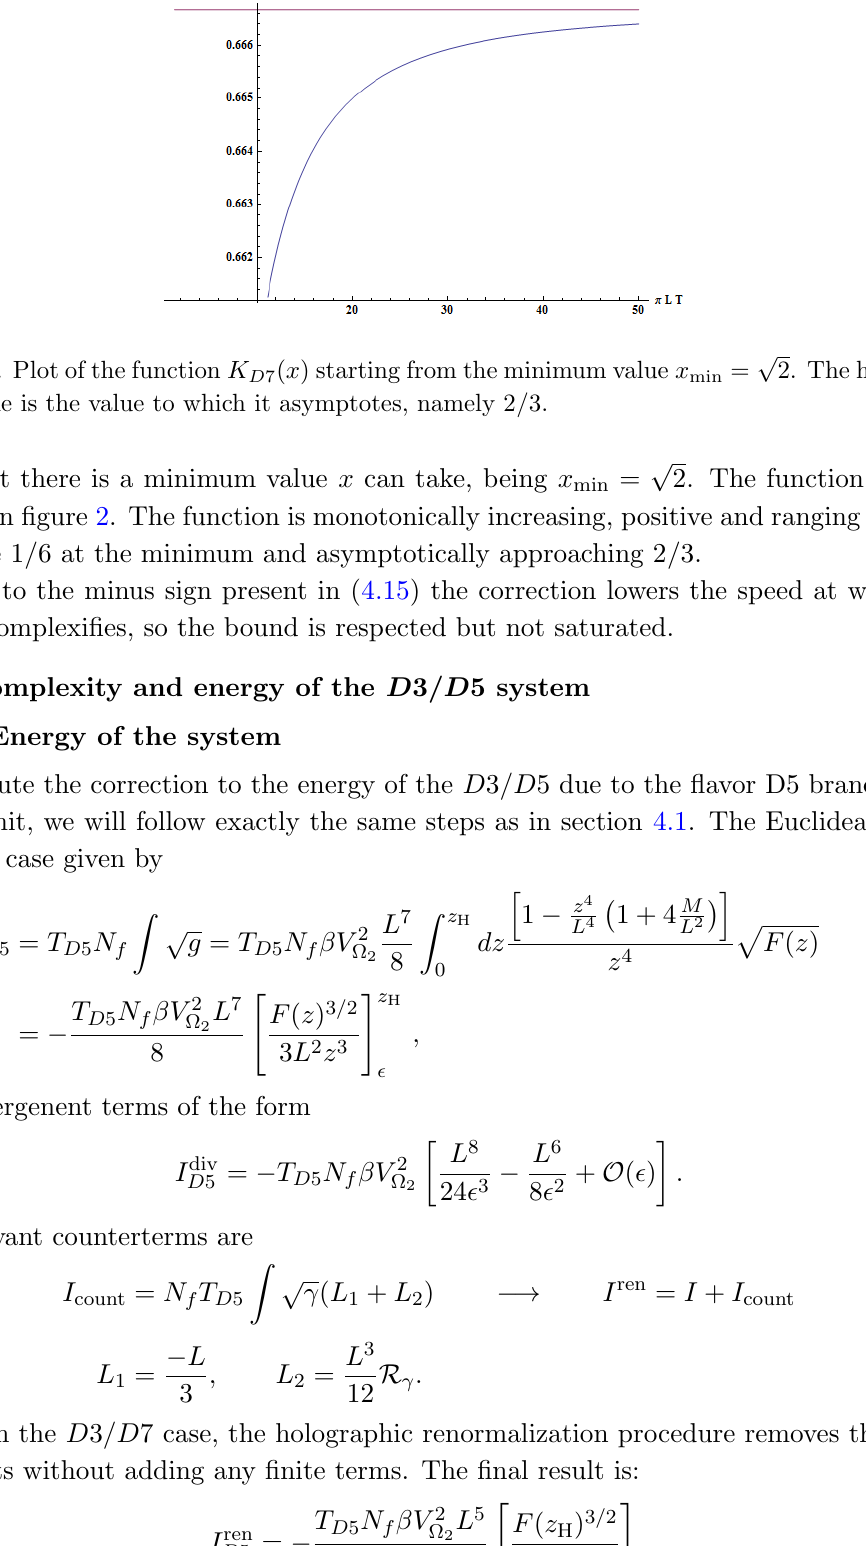
p 2. The horizontal